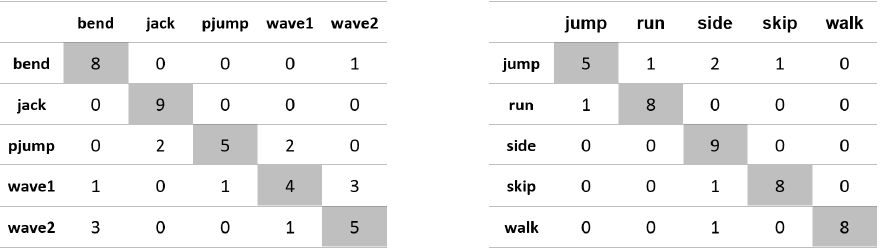
Figure A24. Confusion matrices for the experiment using the ‘upper-occlusion’ database, MBR area and Euclidean